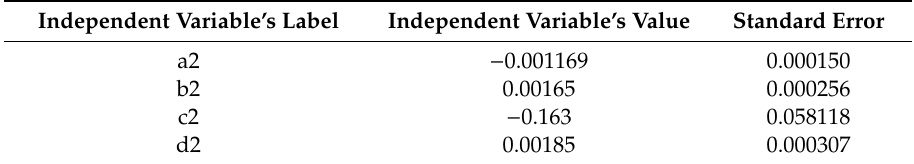
Table 5. Evaluation of fixed parameters for model